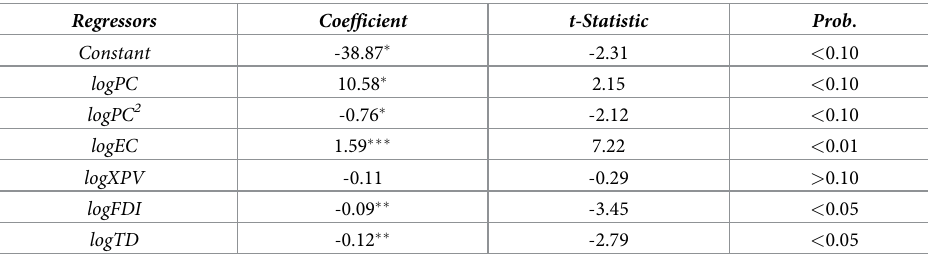
Table 4. Long-term results of cointegration